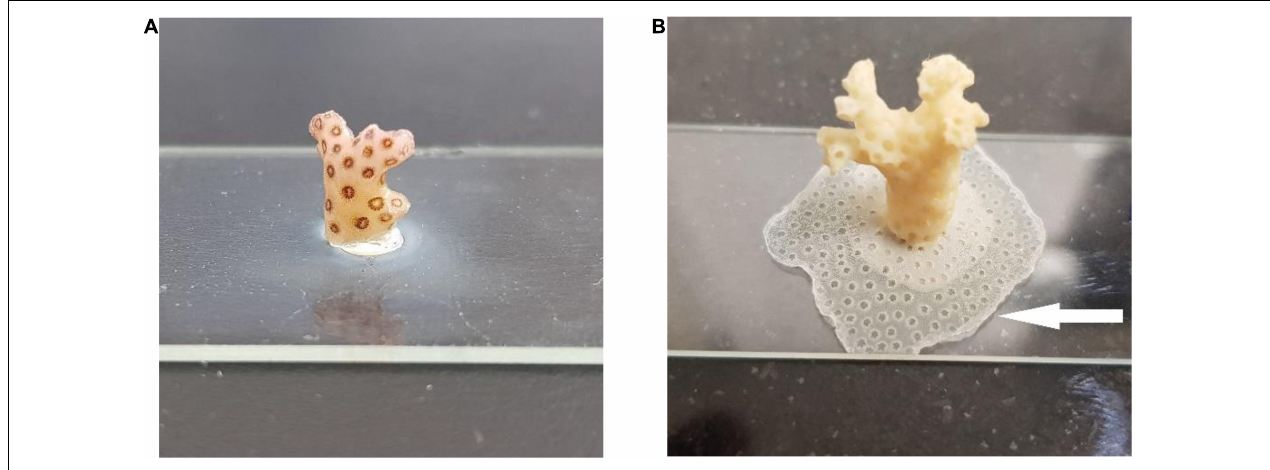
FIGURE 1 | (A) P. damicornis fragment glued to a microscope slide. (B) New skeleton grew horizontally under the experimental conditions (white